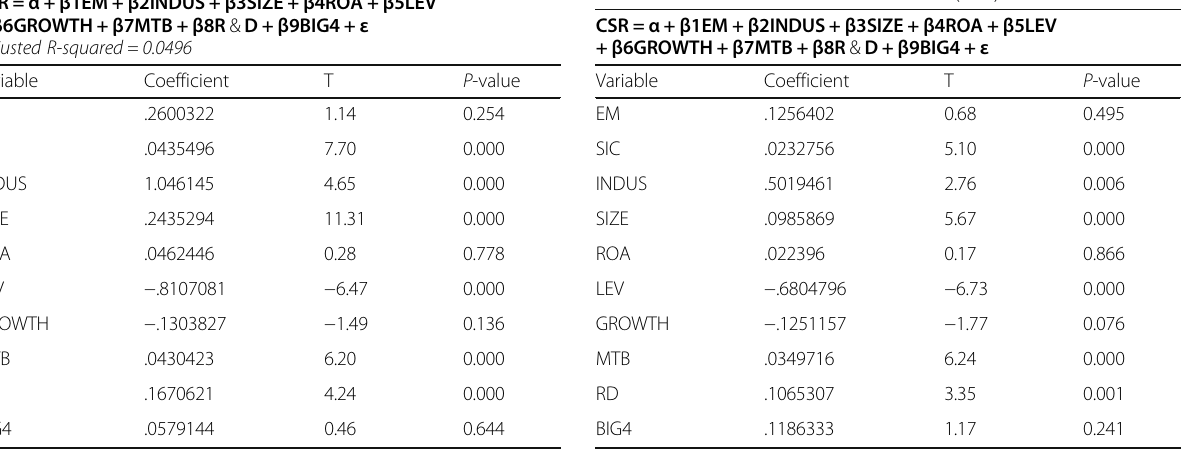
Table 7 Regression results for Model II